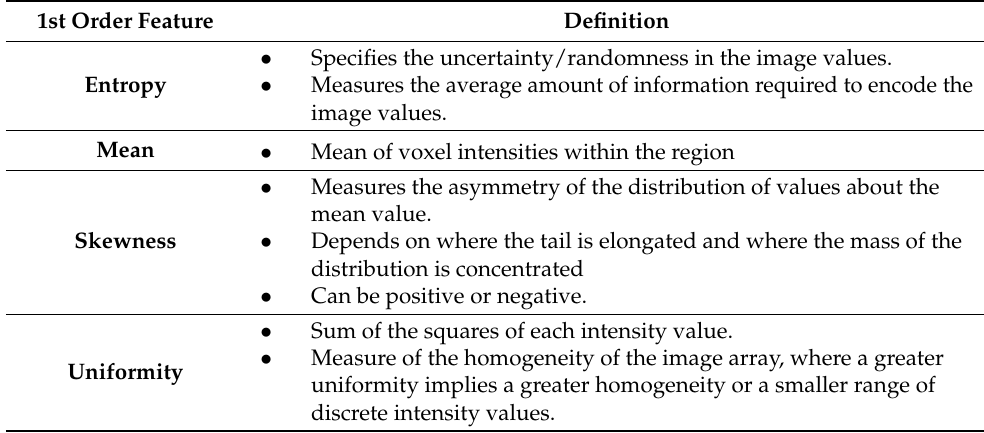
Table 2. Definitions of measured 1st order textural features